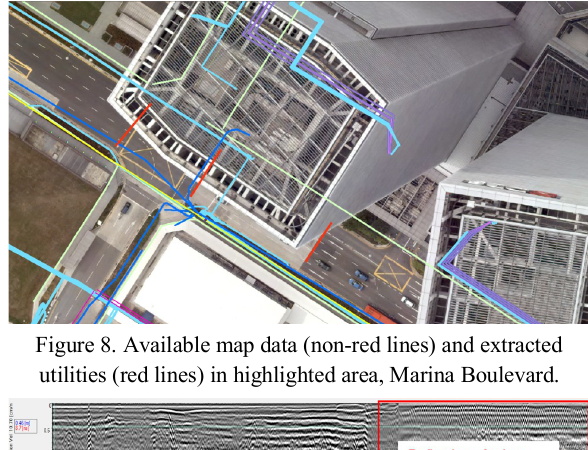
Figure 8. Available map data (non-red lines) and extracted utilities (red lines) in highlighted area, Marina Boulevard.